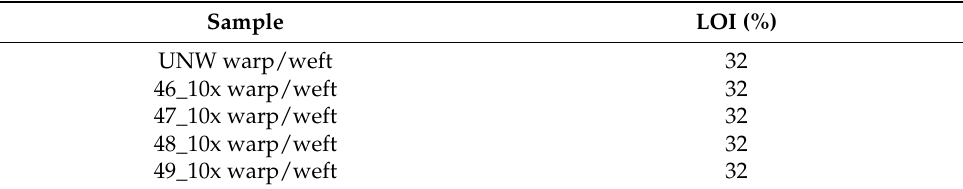
Table 7. LOI of fabrics in warp and weft directions.